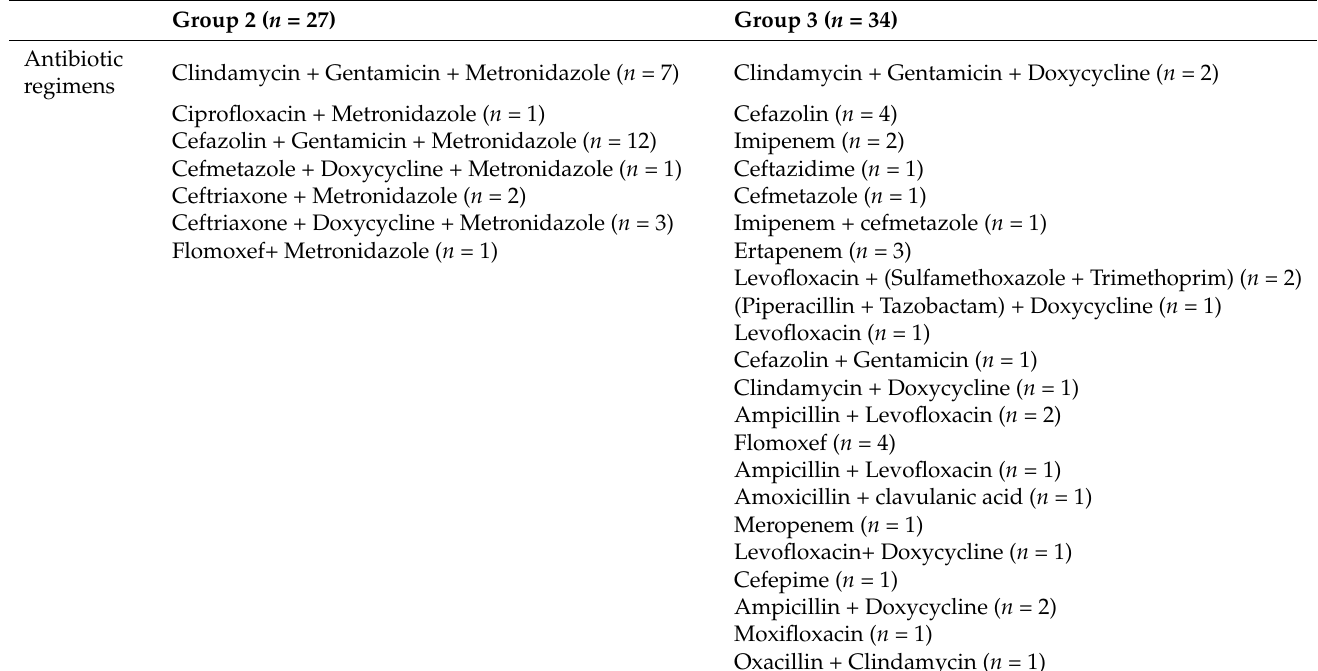
Table 4. Antibiotic regimens in groups 2 and